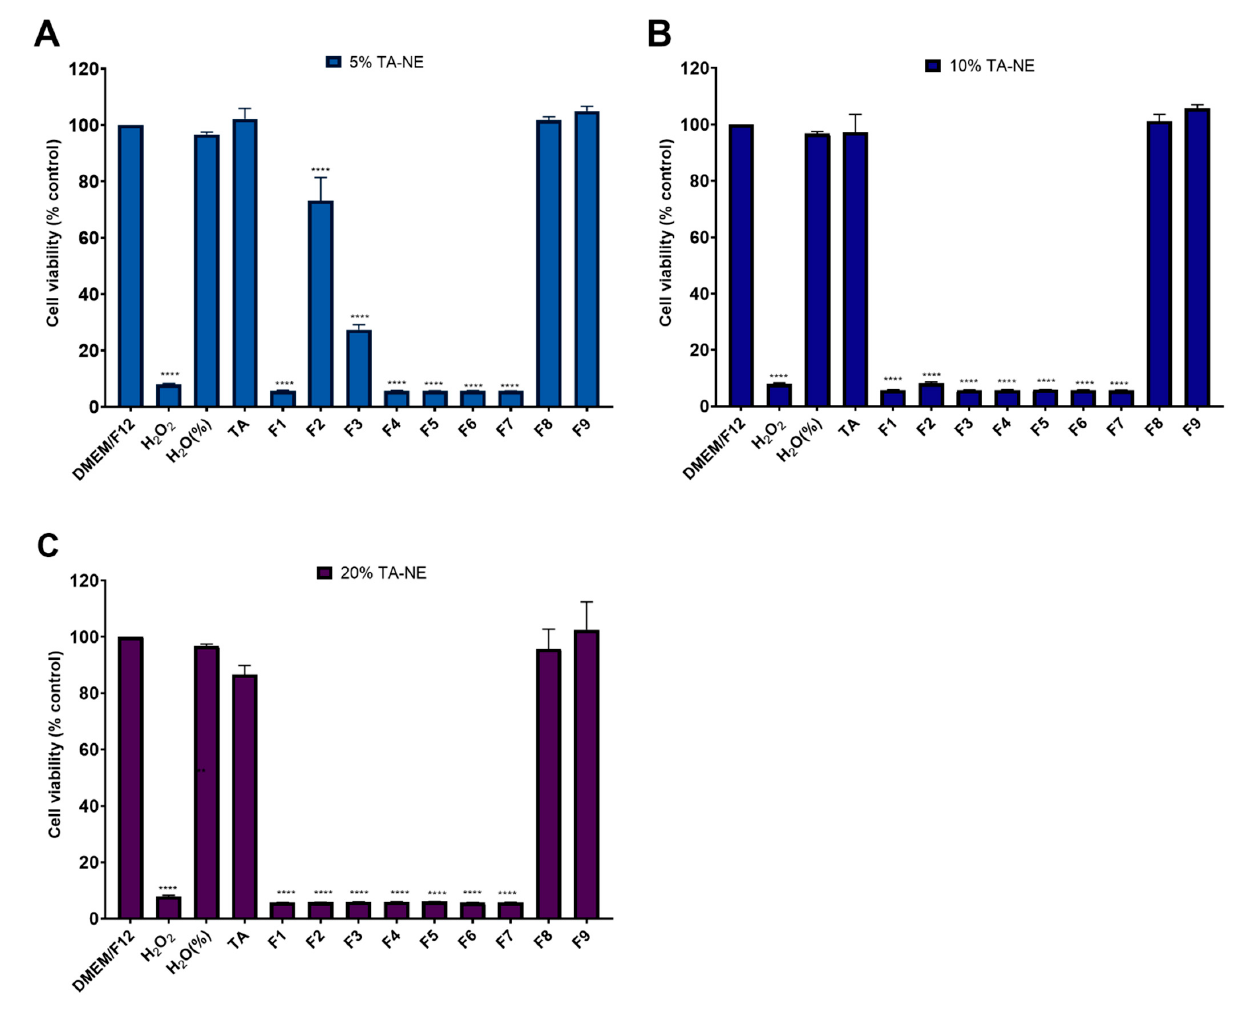
Figure 2. ARPE-19 cell viability upon exposure to TA-loaded nanoemulsons (F1–F9) recorded after 24 h of incubation. Culture media DMEM/F12 and 1 mM H 2 O 2 were used, respectively, as negative and positive controls. The other control was performed by adding water to the culture medium, at the same percentage as that present in the nanoemulsions (%H 2 O), i.e., 5% ( A ), 10% ( B ) and 20% ( C ). The results are the mean of three replicates, and the bars represent the the mean ± standard deviation (S.D.). Statistical significance; **** p < 0.0001 vs. negative control (DMEM/F12). H peroxide; TA-NE: nanoemulsions loading